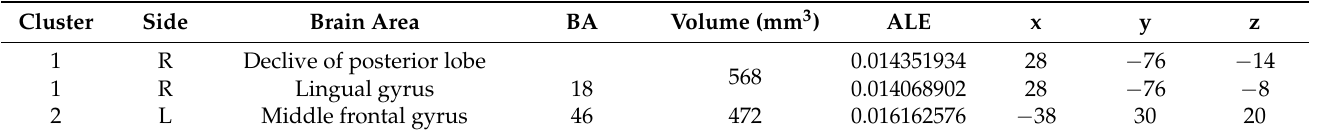
Table 4. Brain areas with increased activities in participants with excessive smartphone use compared with those with regular use.